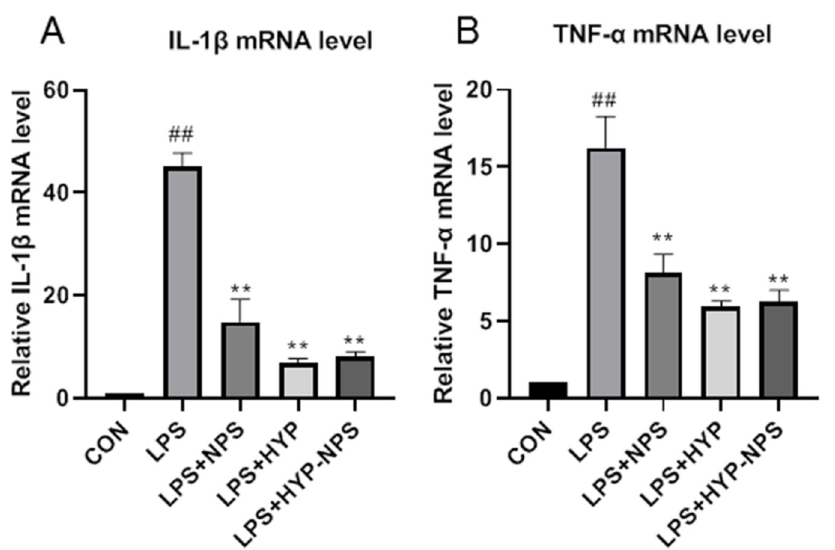
Figure 4. Effects of HYP (5 μ g/mL), LPS + NPS (25 μ g/mL), and LPS + NPS-HYP (25 μ g/mL) on the mRNA expressions of IL-1 β ( A ) and TNF- α ( B ), responding to LPS (1 μ g/mL)-treated RAW264.7